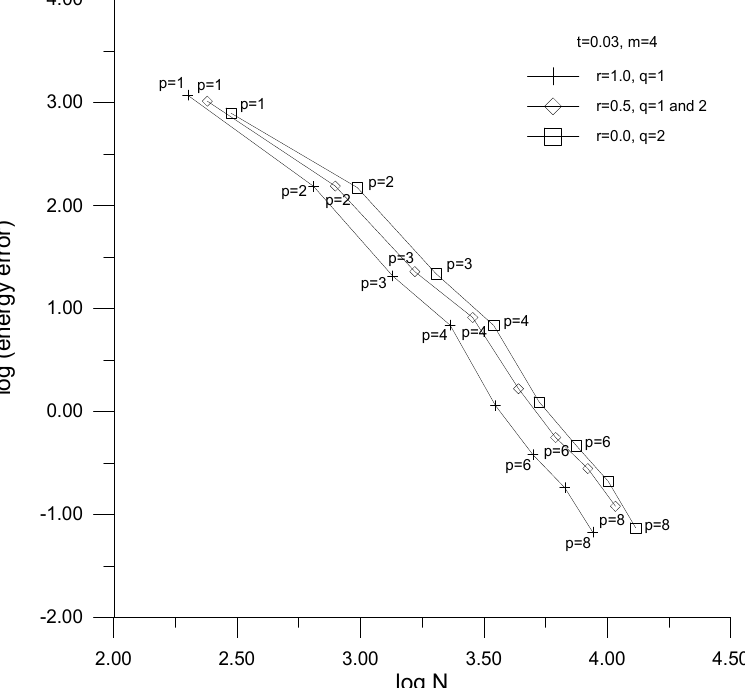
Figure 28. Convergence curves—the membrane shell with the enhanced transition elements. The proposed measure of the approximation error was applied as it guarantees mono- tonicity of the energy approximation error with changing value of p ≡ π , while the simple sum of both parts of the energy (equal to the electro-mechanical co-energy) may not. Note that such monotonicity is a must in the case of error-controlled adaptivity suggested in Reference